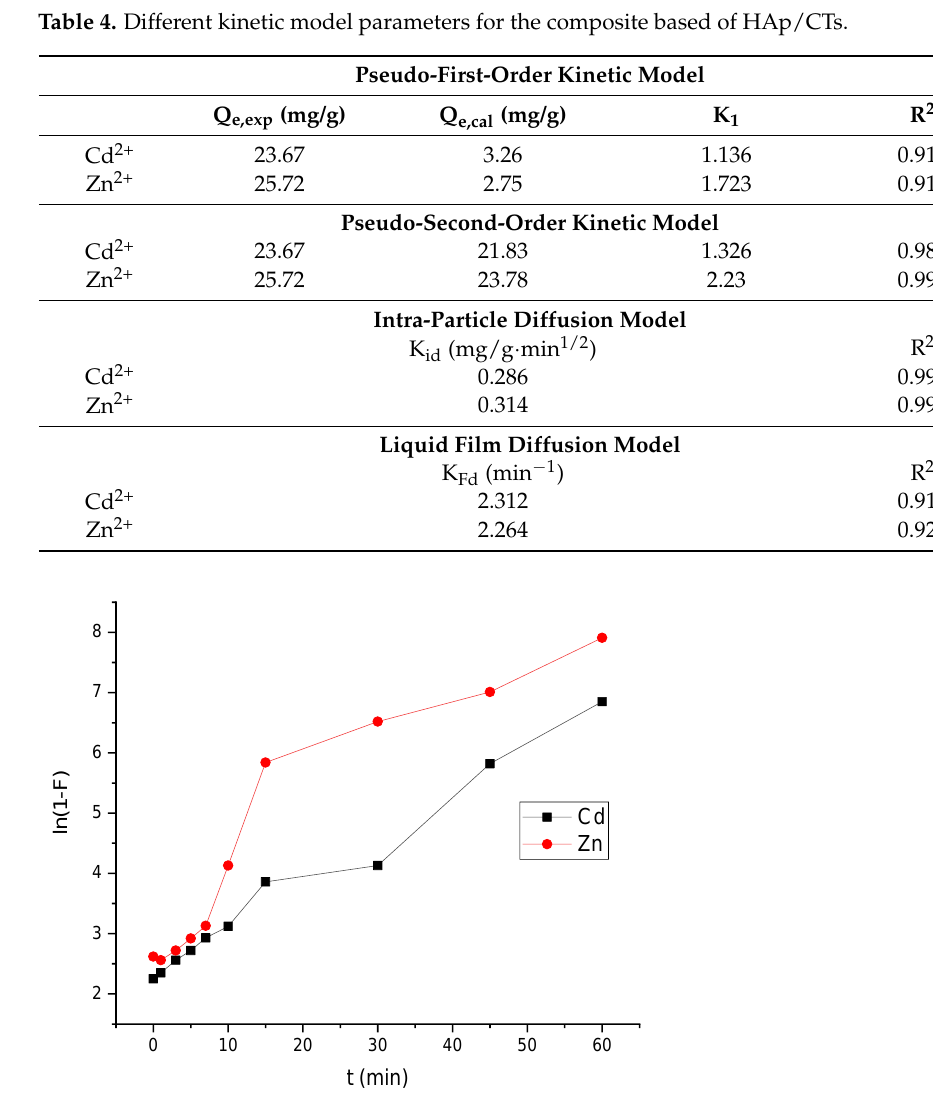
Table 4. Different kinetic model parameters for the composite based of HAp/CTs.